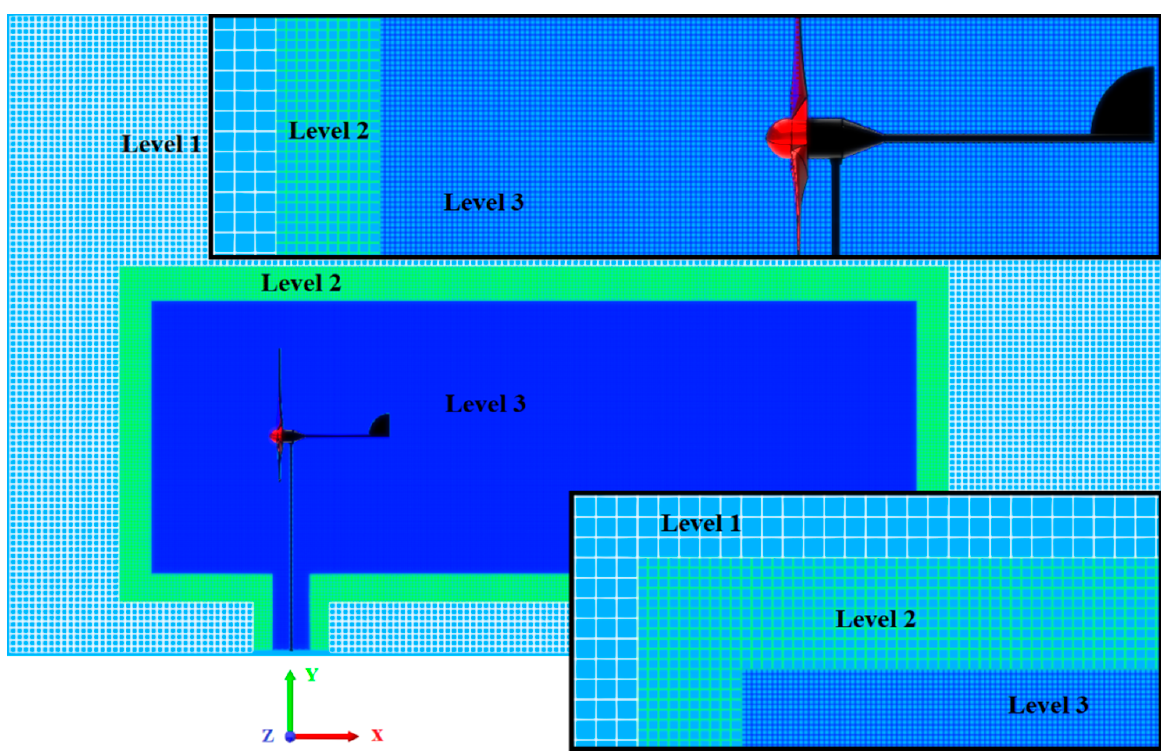
Figure 5. The discrete scheme of computational domain for the wind turbine wake flows (Z = 0).